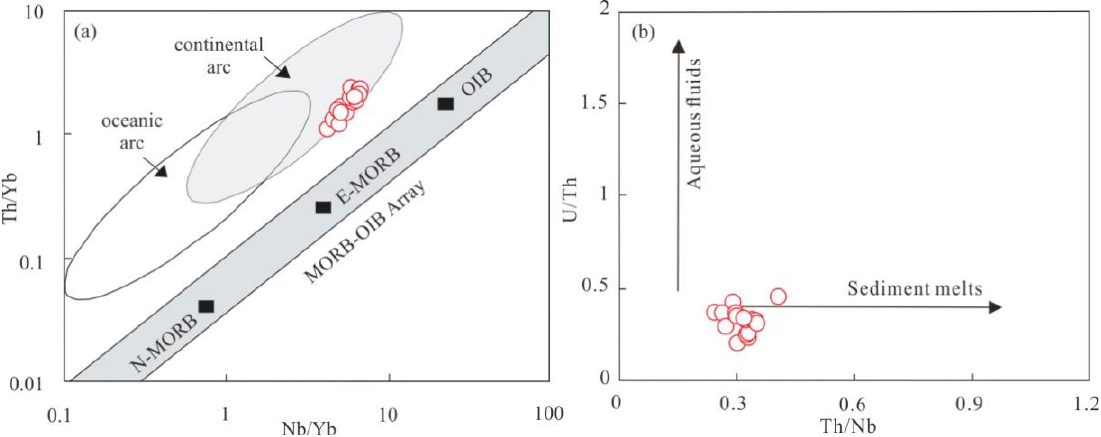
Figure 6. Th/Yb vs. Nb/Yb ( a ) [52] and U/Th vs. Th/Nb ( b ) [53] of equilibrium melt of hornblendes from the Paleoproterozoic Gaositai hornblendite.